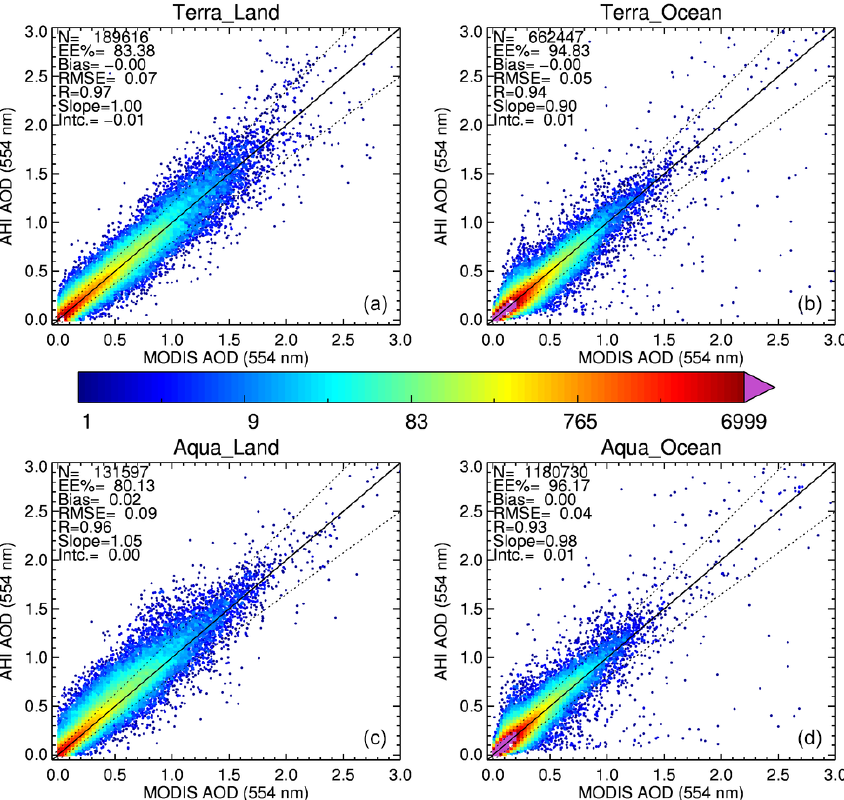
Figure 5. Density scatterplots of retrieved AOD at 554nm derived from AHI radiances using the new DT AHI algorithm versus retrieved AOD at 554nm from the operational MODIS Collection 6.1 algorithm, collocated in time and space. (a, b) Terra MODIS. (c, d) Aqua MODIS. Panels (a, c) show results from the overland retrieval. Panels (b, d) show results from the over-ocean retrieval. The same collocation statistics are displayed as in Fig.